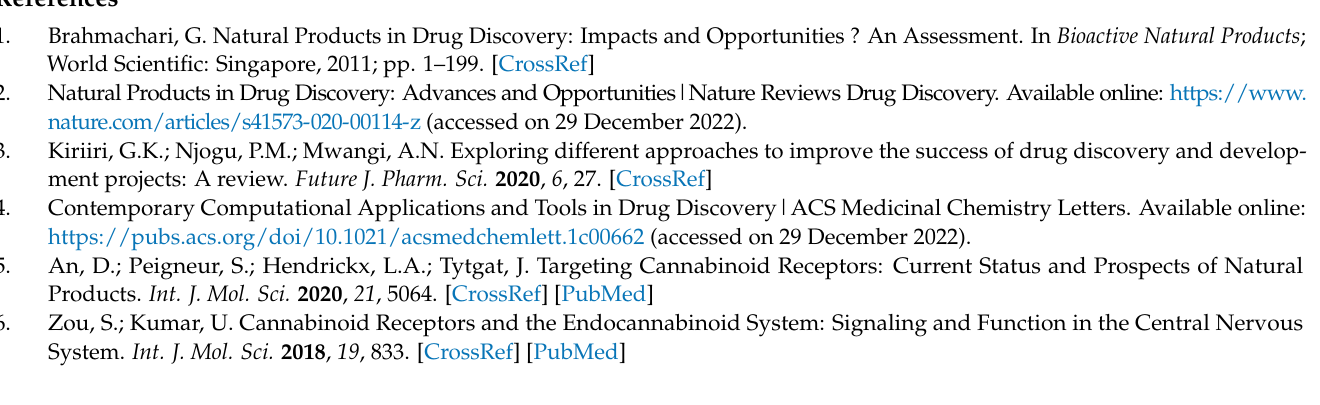
Table S2: Docking results for all tested compounds against native ligands of CB2 agonist (PDB: 6KPF) Details of molecular dynamics simulation for E3R , simplicildone J ( 10 ), lobaric acid ( 110 ), mollicellin Q ( 101 ), garcinisidone E ( 215 ), mollicellin P ( 100 ), paucinervin Q ( 149 ), and boremexin C ( 161 ); ADMET properties table for all tested depsidone derivatives; docking results for all tested compounds against native ligands of CB2 agonist (PDB: